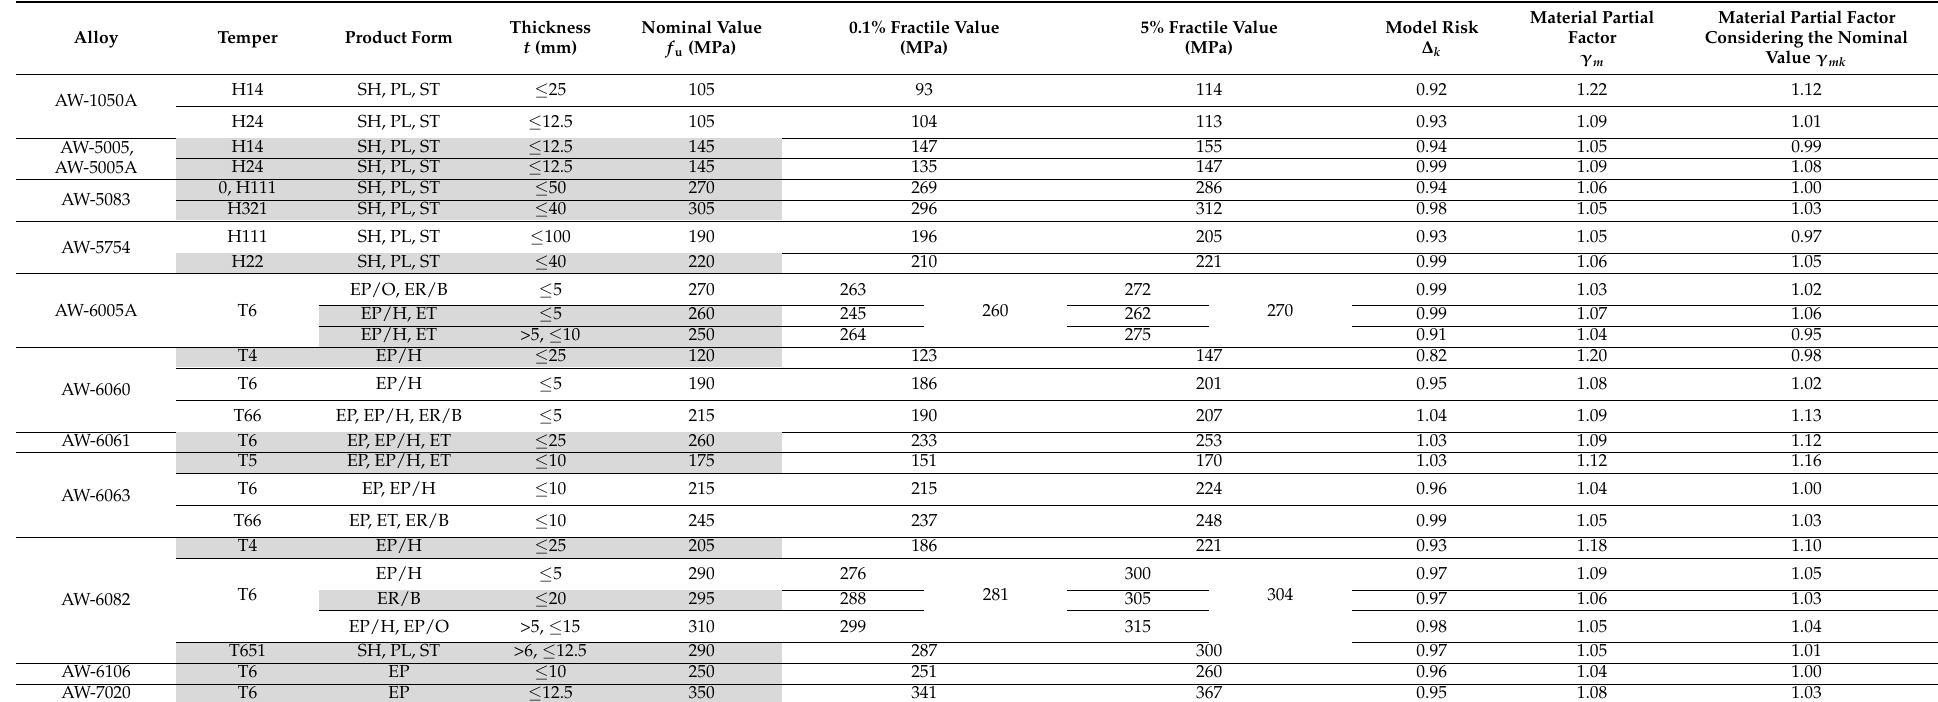
Table 5. Material partial factor determination for ultimate tensile